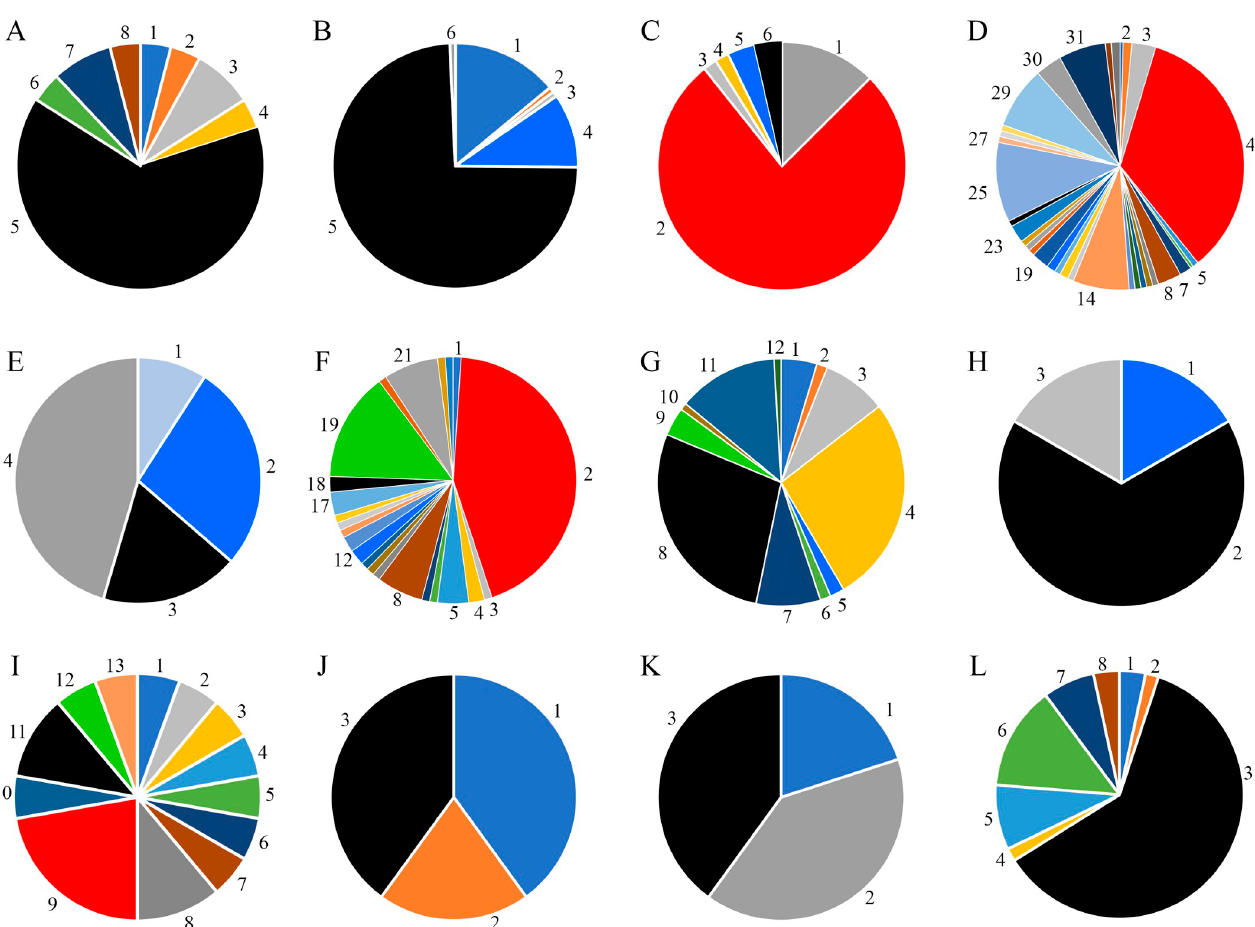
Fig 4. Distribution of P. pseudoalcaligenes CECT5344 sRNAs differentially expressed among bacteria. The bacterial sRNAs were analyzed using the GLASSgo software. 100% represents the total sRNAs sequences found in all bacterial species, considering the number of sequences as well as the % of identity (with at least 60% identity among sequences). Only sRNAs with homologs in more than two species are shown. The specific contribution (%) of each specie is indicated when it is higher than > 1%. A. (sRNA14): 1, E . coli (4.0); 2, Oceanimonas sp . (4.0); 3, P . chlororaphis (8.0); 4, P . plecoglossicida (4.0); 5, P . pseudoalcaligenes (64.0); 6, Shigella dysenteriae (4.0); 7, Shigella sonnei (8.0); 8, Yersinia enterocolitica (4.0). B. (sRNA149): 1, P . stutzeri (12.5); 2, P . aeruginosa (76.8); 3, P . fulva (1.8); 4, P . mandelii (1.8); 5, P . mendocina (3.6); 6, P . pseudoalcaligenes (3.6). C. (sRNA184): 2, Azotobacter vinelandii (1.2); 3, Pseudomonadaceae bacterium (3.1); 4, P . aeruginosa (34.6); 7, P . brassicacearum (1.5); 8, P . chlororaphis (3.1); 14, P . fluorescens (7.3); 16, P . knackmussii (1.2); 18, P . mendocina (1.2); 19, P . monteilii (2.3); 23, P . protegens (2.3); 25, P . putida (10.4); 29, Pseudomonas sp. (8.1); 30, P . stutzeri (3.5); 31, P . syringae (6.2); 33, uncultured soil microorganism (1.2); D. (sRNA222): 1, P . fulva (9.1); 2, P . mendocina (27.3); 3, P . pseudoalcaligenes (18.2); 4, P . stutzeri (45.5). E. (sRNA258): 2, P . aeruginosa (43.9); 4, P . brassicacearum (2); 5, P . chlororaphis (4.1); 8, P . fluorescens (6.1); 12, P . mendocina (2); 13, P . monteilii (2); 17, P . protegens (3.1); 18, P . pseudoalcaligenes (2); 19, P . putida (14.3); 21, Pseudomonas . sp. (7.1). F. (sRNA431). 1, P . chlororaphis (4.7); 2, P . deceptionensis (1.4); 3, P . entomophila (8.4); 4, P . fluorescens (27.1); 5, P . mendocina (1.9); 6, P . mosselii (1.4); 7, P . protegens (8.4); 8, P . pseudoalcaligenes (28); 9, P . putida (3.7); 11, Pseudomonas . sp. (13.1). G. (sRNA455): 1, P . mendocina (16.7); 2, P . pseudoalcaligenes (66.7), 3, Helicobacter cetorum (16.7). H. (sRNA559): 1, Alcanivorax dieselolei (5.5); 2, Comamonas testosteroni (5.5); 3, Cronobacter muytjensii (5.5); 4, Cronobacter universalis (5.5); 5, Enterobacter cloacae (5.5); 6, Klebsiella oxytoca (5.5); 7, Methylophaga frappieri (5.5); 8, Pantoea sp . (11.1); 9, P . aeruginosa (22.2); 10, P . fluorescens (5.5); 11, P . pseudoalcaligenes (11.1); 12, P . putida (5.5); 13, Pseudomonas sp. (5.5); I. (sRNA601): 1, P . mendocina (40); 2, P . fulva (20); 3, P . pseudoalcaligenes (40). J. (sRNA649): 1, P . extremaustralis (20); 2, P . stutzeri (40); 3, P . pseudoalcaligenes (40). K. (sRNA683): 1, E . coli (3.4); 2, Oceanimonas sp. (1.7); 3, P . pseudoalcaligenes (61); 4. Rahnella aquatilis (1.7); 5, Shigella boydii (8.5); 6. Shigella flexneri (13.6); 7, Shigella sonnei (6.8); 8, Vibrio vulnificus